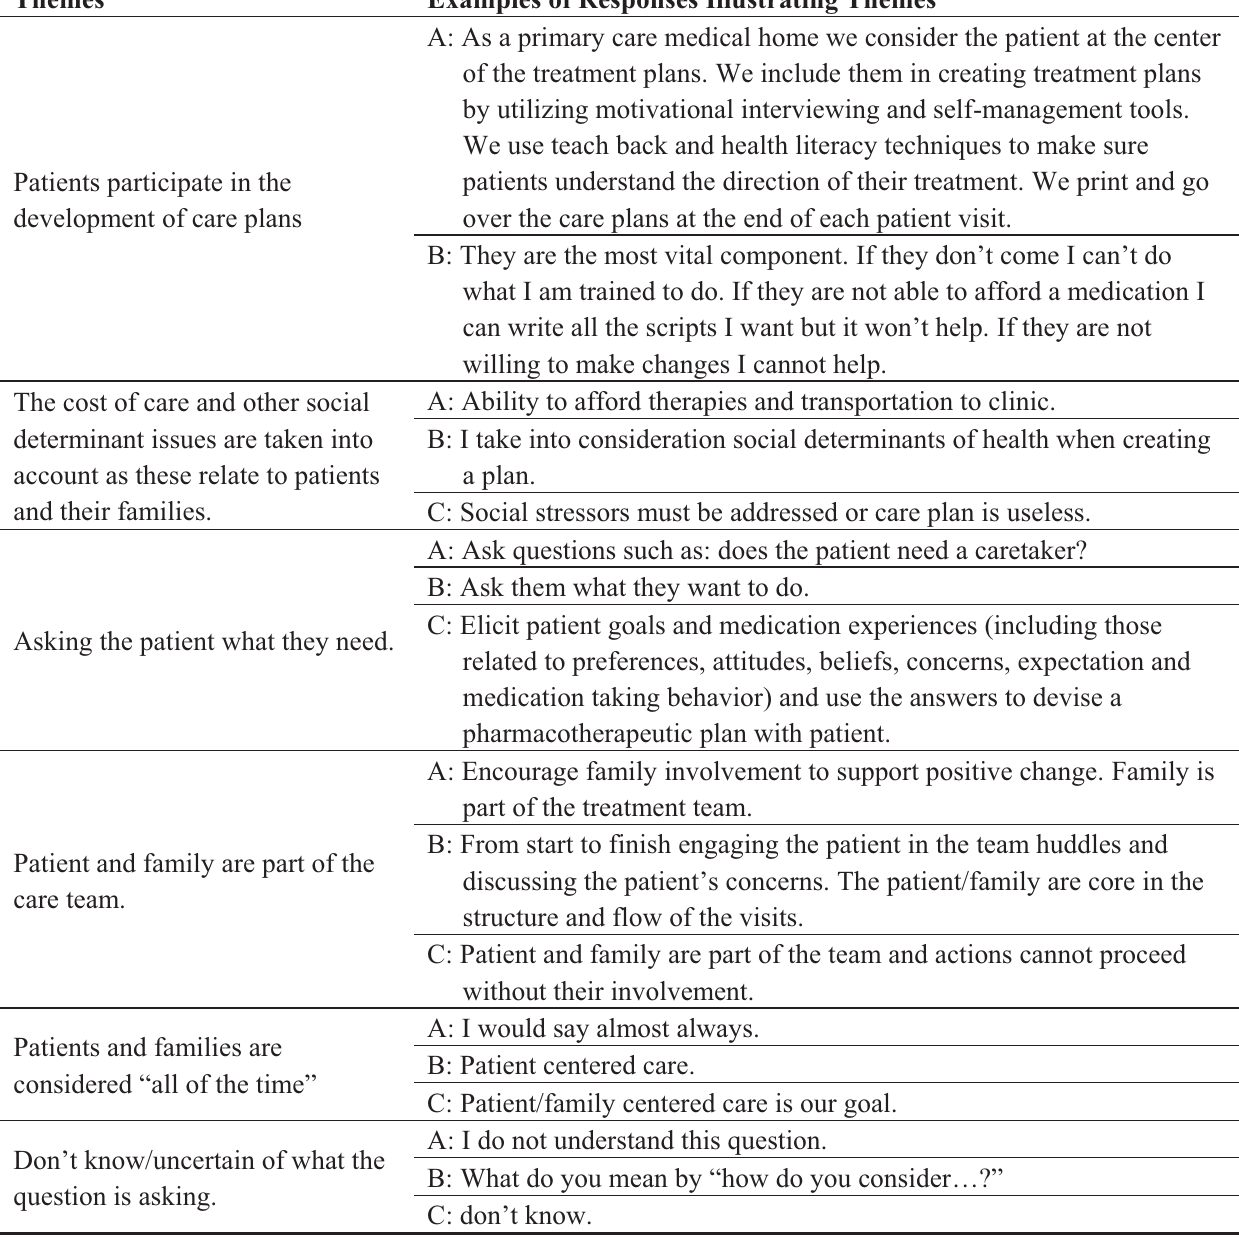
Table 8. Six qualitative themes emergent from network user survey data question: how is the patient and family considered in care